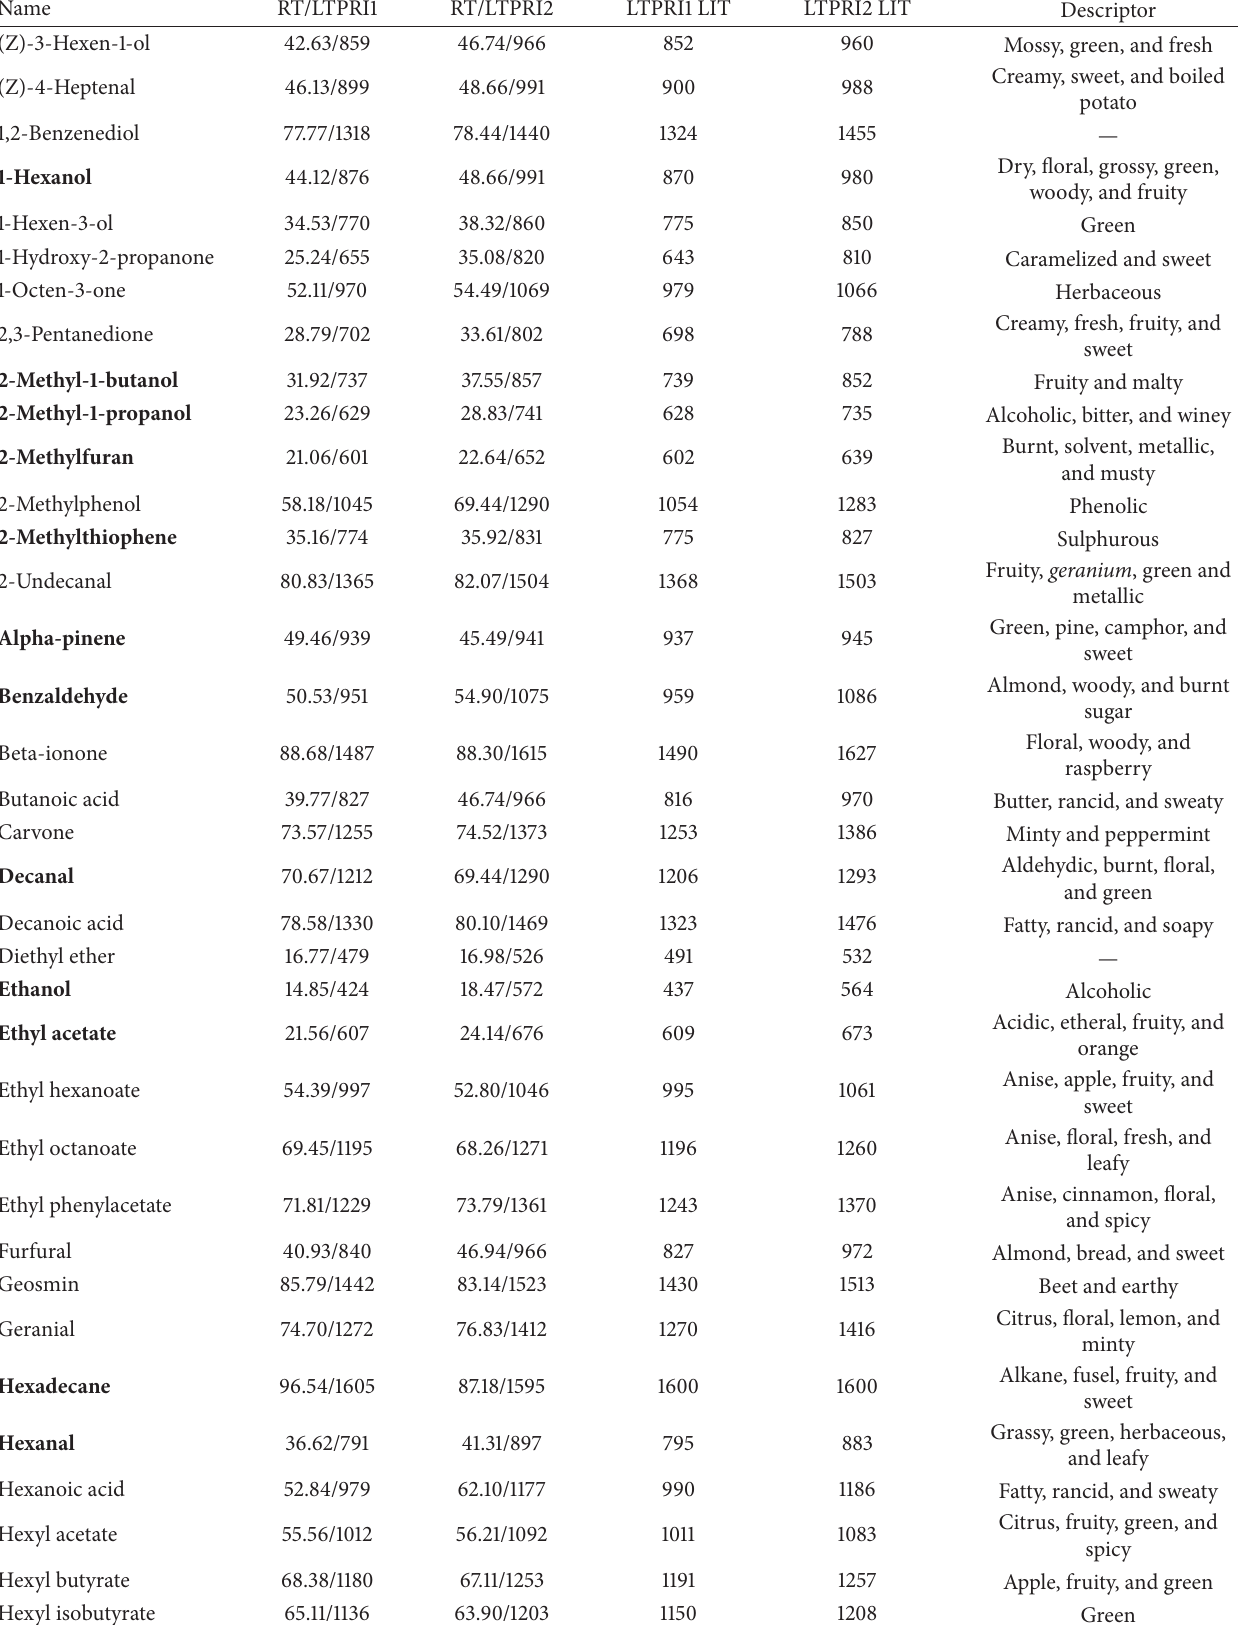
Table 5: Compounds detected in raw spirit